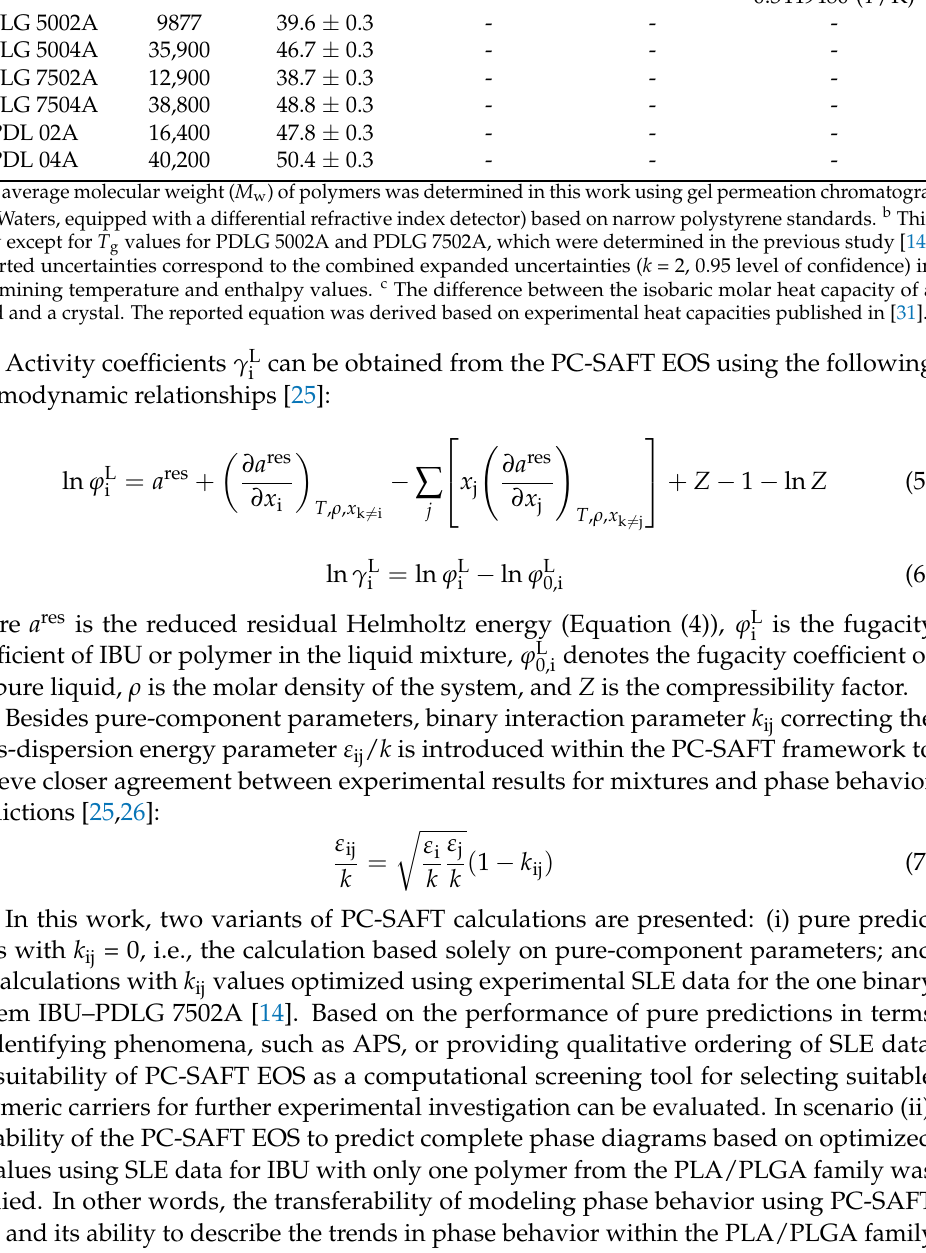
Table 3. Pure-component physiochemical properties. Compound